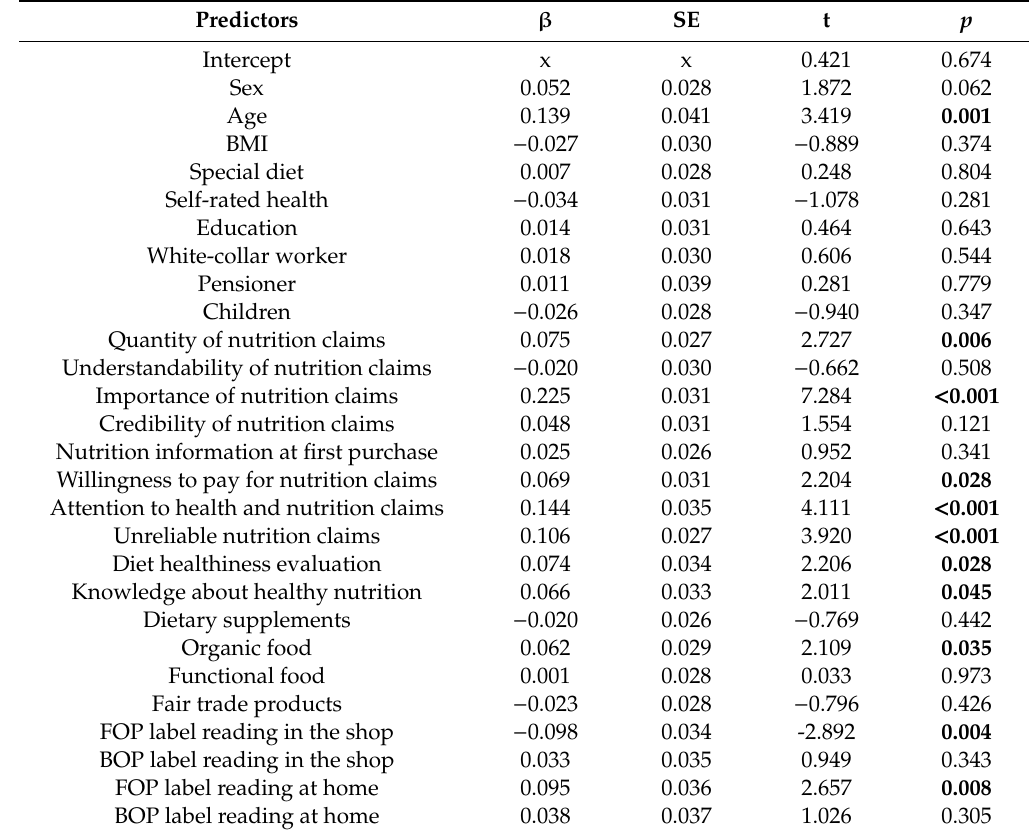
Table 5. Selected predictors of the importance attached to salt content information on food packaging (the initial multiple regression model).